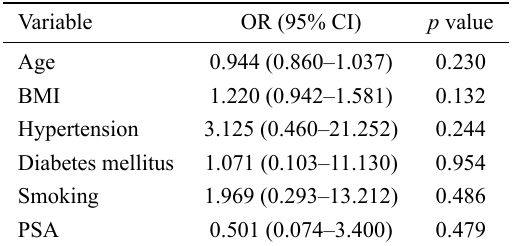
Table 4. Multivariate analysis of various factors potentially affecting LUTS for in patients over 50 years of